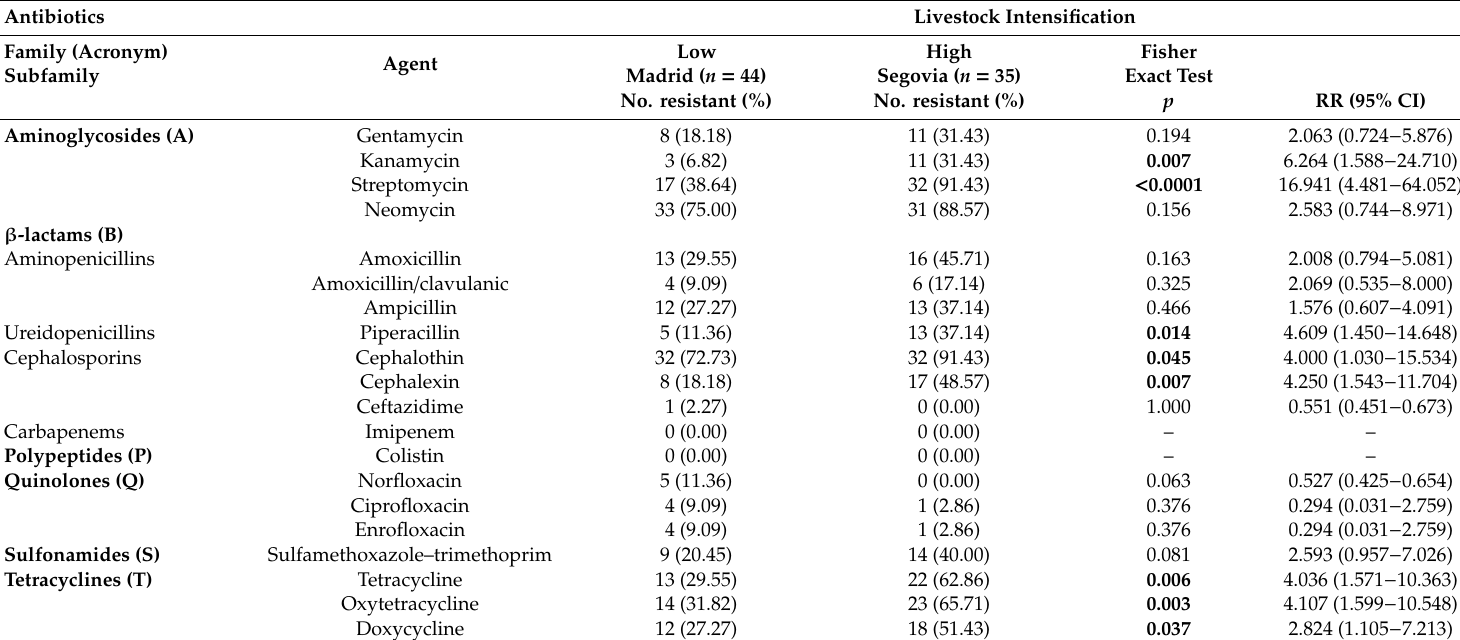
Table 1. Antibiotic resistance of E. coli isolates from red kite droppings sampled in two areas with low (Madrid) or high (Segovia) livestock intensification farming. The numbers of resistant and susceptible isolates between areas were compared with Fisher’s exact tests and relative risk (RR) with 95% confidence intervals (CI). Significant di ff erences are highlighted in